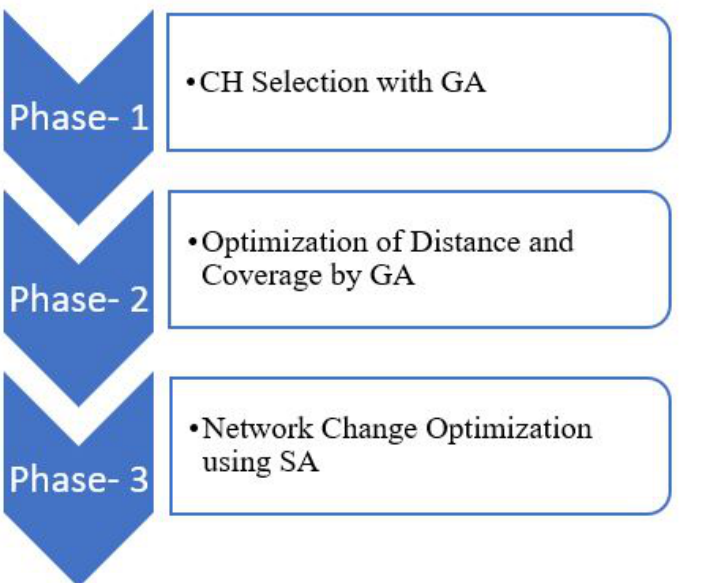
Figure 6. The flow of the Genetic Algorithm-GA-Simulated Annealing (GA-GA-SA) clustering